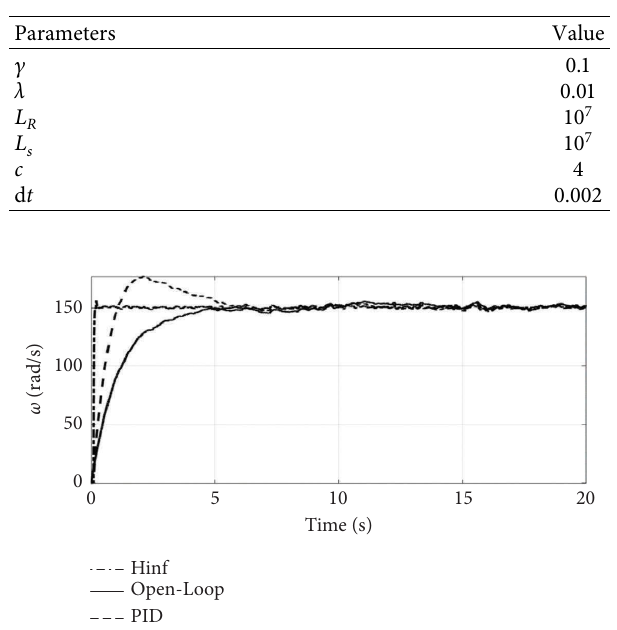
Figure 6: Te angular velocity of the frst-order system for τ � 0 . 1s and stochastic disturbance.